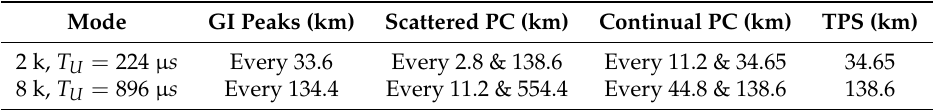
Table 1. Ambiguity peaks location in the range domain for the 2 k and 8 k modes, due to Guard Interval (GI), Pilot Carriers (PC) and Transport Parameter Signaling